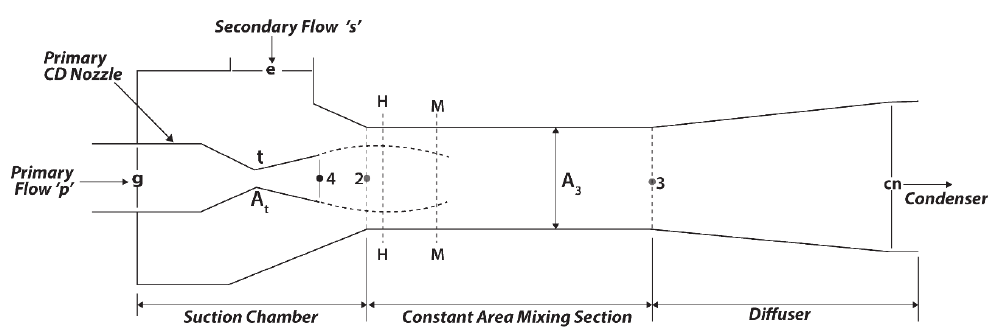
Figure 2. Ejector schematic.